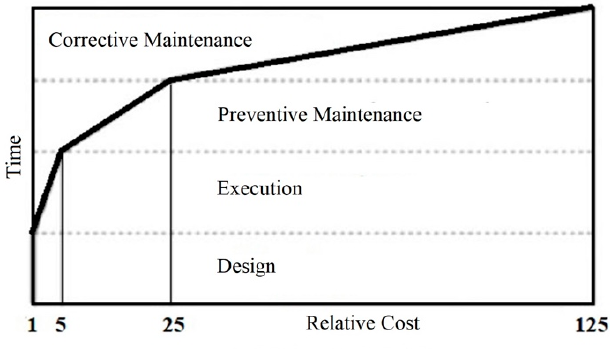
Figure 6. The Law of Fives